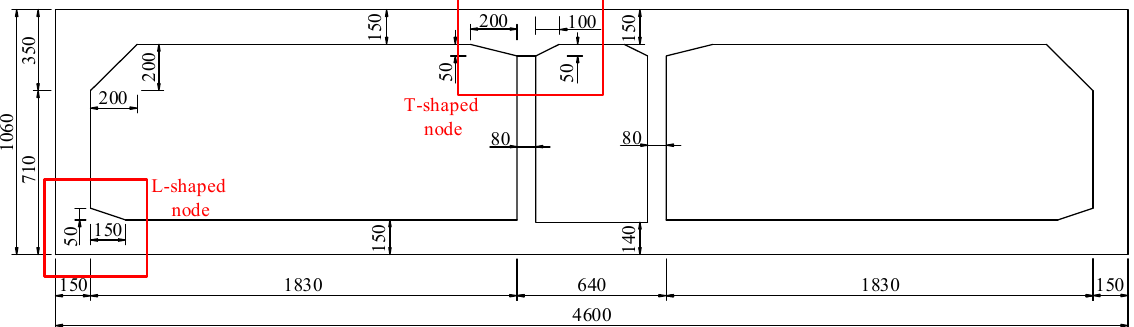
Figure 2. Cross section of the immersed tunnel (unit: cm).